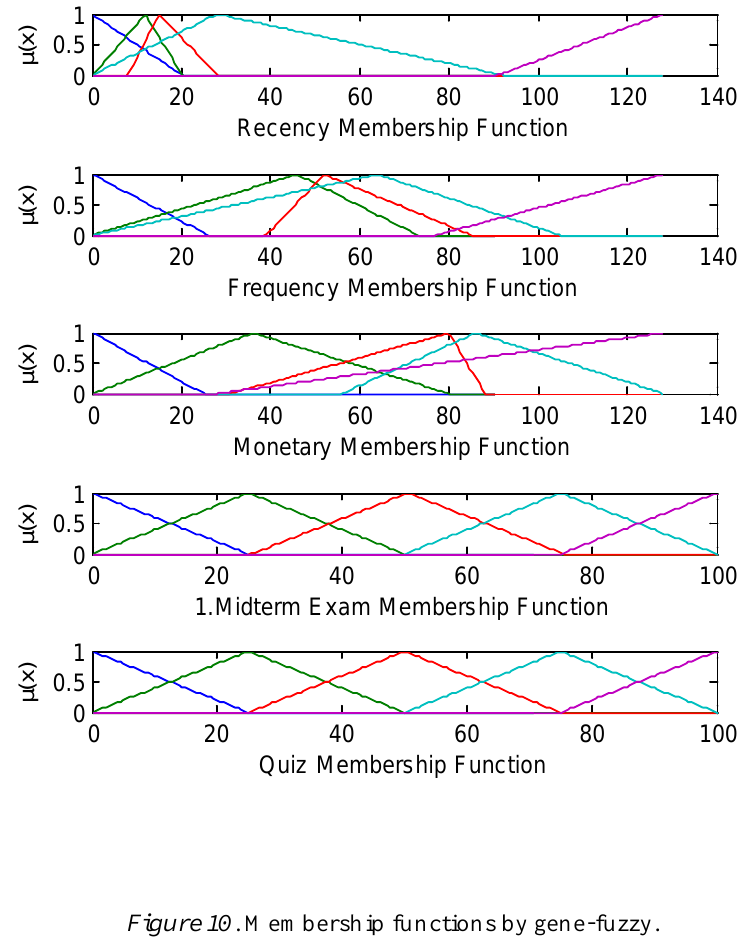
Figure 10 . Membership functions by